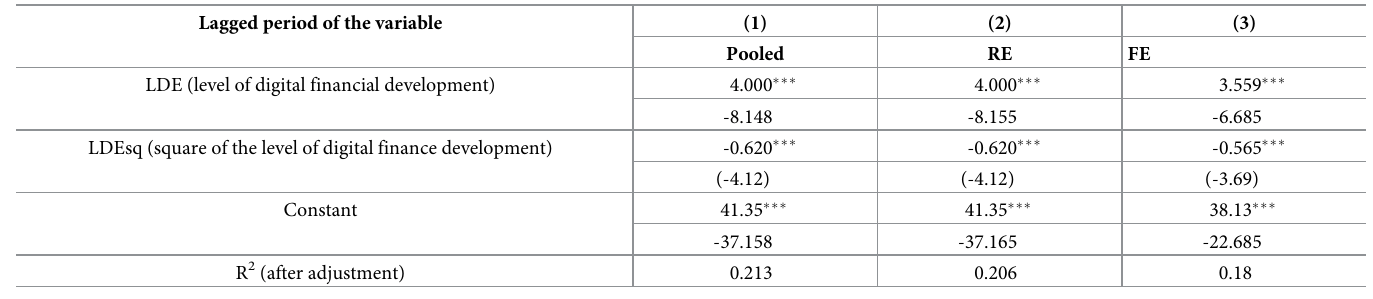
Table 4. Robustness test results. Lagged period of the